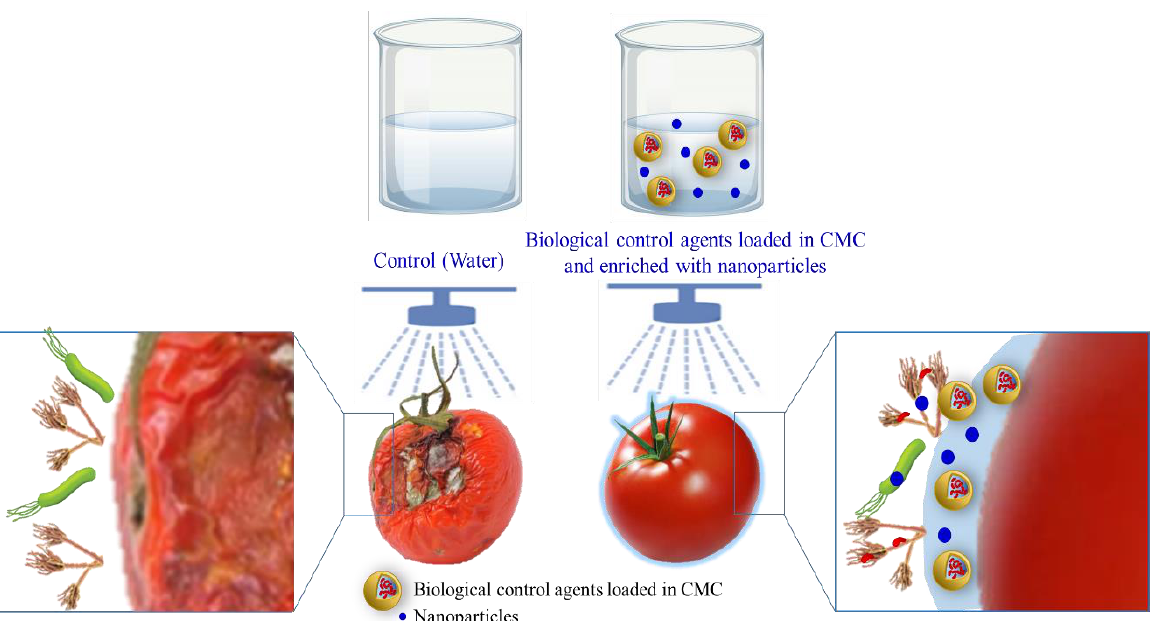
Figure 10. The use of edible active antimicrobial coatings based on carboxymethyl cellulose (CMC) enriched with biological control agents and nanoparticles.